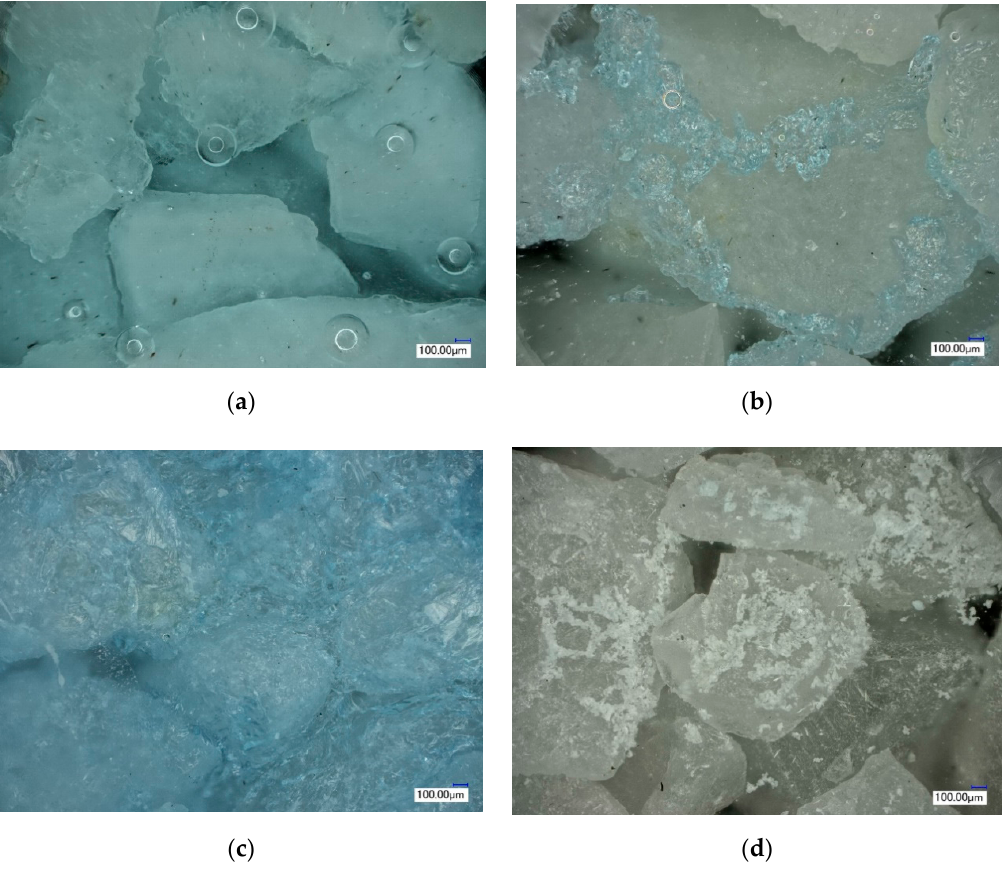
Figure 5. Observation of different forms of soluble salts in samples by ultra-depth-of-field microscope. ( a ) salt solution; ( b ) crystalline brine accumulation zone; ( c ) salt crystalline zone; ( d ) salt completely dried.